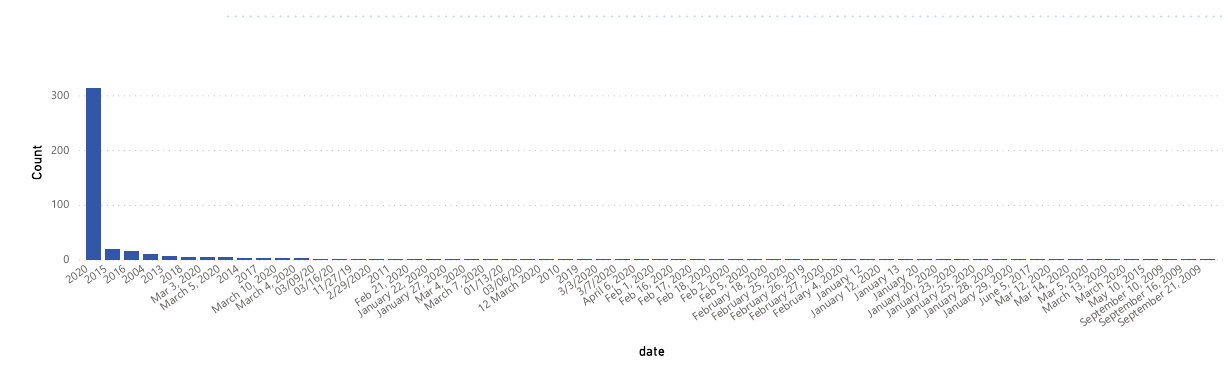
Figure 2. Metadata of some datasets related to the age of the patient with peculiar distributions.